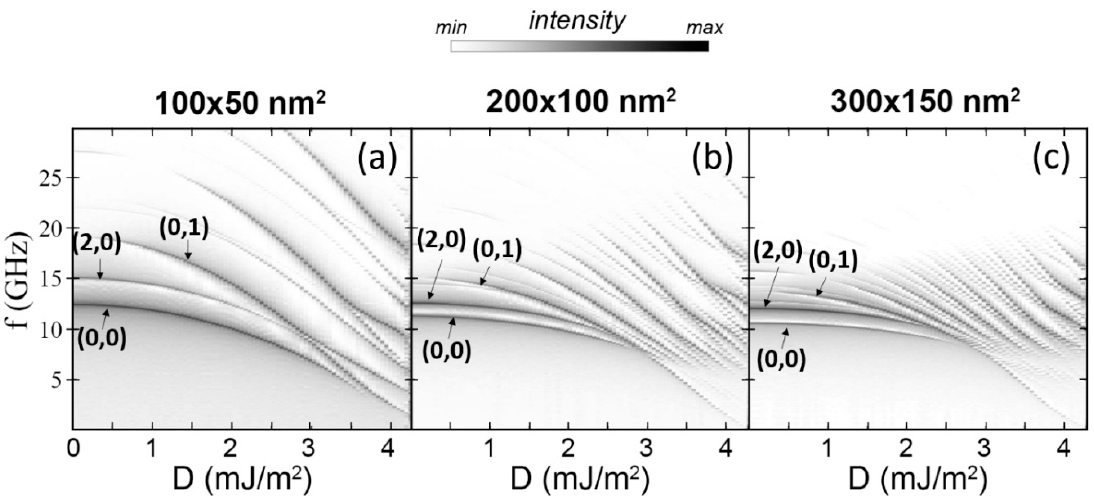
Figure 6. Dependence of the frequencies of the spin wave eigenmodes on the DMI constant D for the elliptical dot of lateral dimensions 100 × 50 nm 2 ( a ), 200 × 100 nm 2 ( b ), 300 × 150 nm 2 ( c ). It is seen that the frequency of the (0,1) mode decreases more rapidly that the two lower modes, so mode crossing is observed for D around 3 mJ/m 2 and then the mode becomes soft, driving the transition to a non-uniform chiral ground